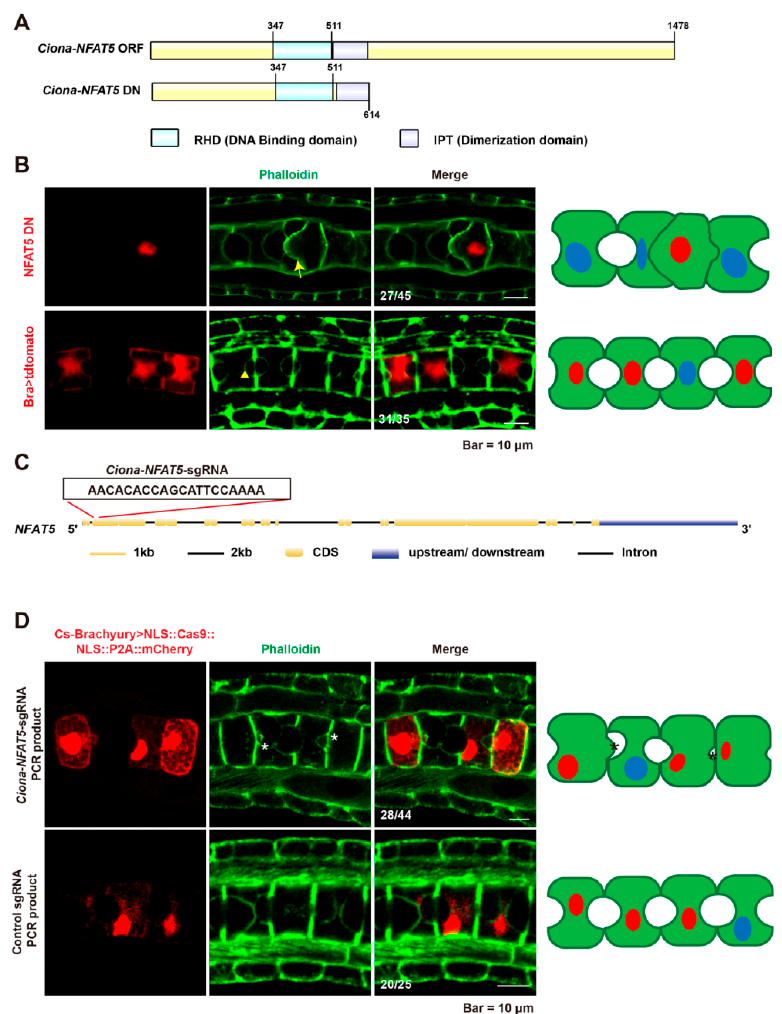
Figure 2. Loss of NFAT5 function resulted in disruption of lumen formation and expansion. ( A ) Schematic diagrams of the domains in wild type and dominant negative format of Ciona -NFAT5. ( B ) Overexpression of dominant negative Ciona NFAT5 led to the failure of lumen formation. ( C ) The sequences and the targeted site of single guide RNA (sgRNA) for Ci-NFAT5 knockout by CRISPR- Cas9. ( D ) Confocal images of Ciona - NFAT5 knockout embryos and control ones at the late tailbud stage. Asterisk represents defects on notochord lumen expansion. The ratio of embryos with phe- notypes was labeled. The schematic images on the right side of the confocal images described the phenotypes of the Ciona - NFAT5 knockdown/out and control. The green, blue, and red ar- eas represented the notochord cells, the nuclei, and the nuclei in cells expressed in Bra >NFAT5- DN::tdtomato/ Bra >NLS:Cas9:NLS:P2A:mCherry (red), respectively. The scale bar represents 10 µ